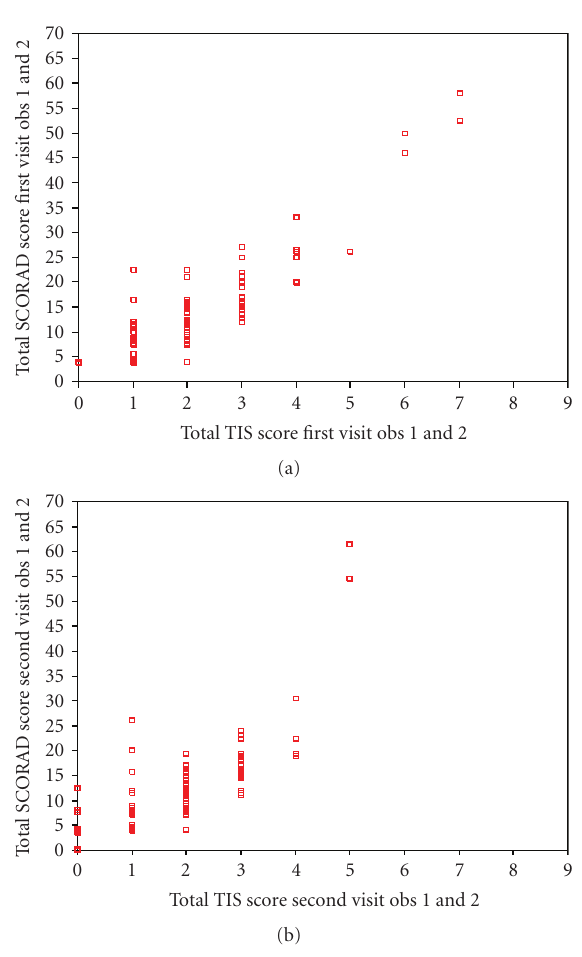
Figure 1: Correlation between TIS and SCORAD. Observations from the two independent observers (obs 1 and 2) are displayed in one figure ((a) first visit, (b) second visit).